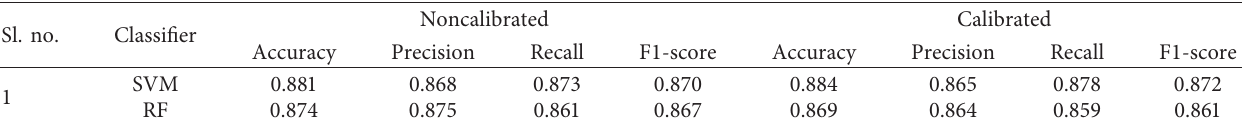
Table 8: Classification result of a single classifier